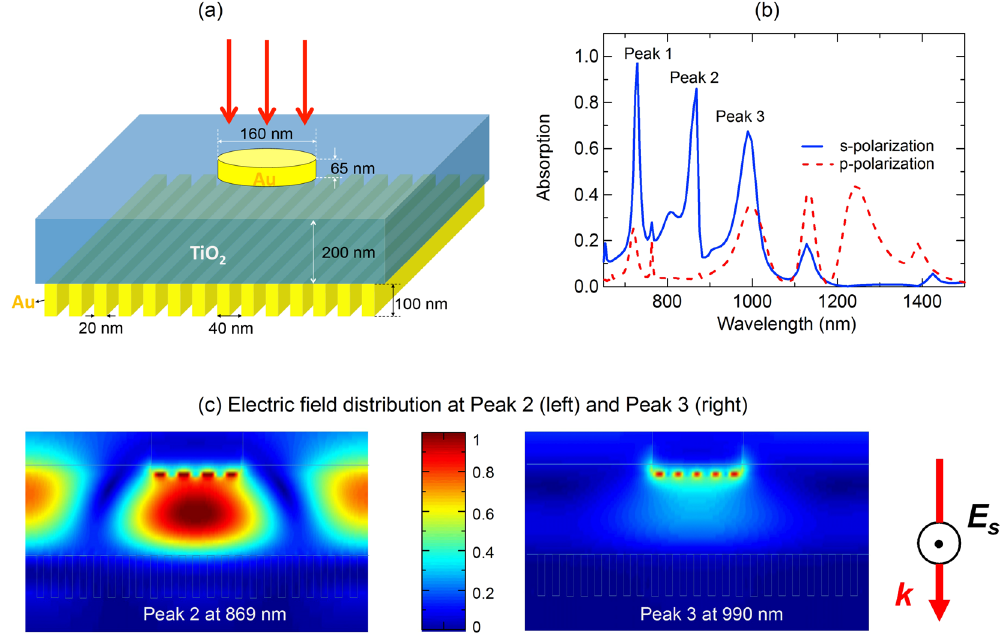
Figure 6. ( a ) Schematic of the narrowband polarization sensitive perfect absorber. Au nano-disk has diameter of 160 nm and thickness of 65 nm. TiO2 layer has thickness of 200 nm, and the Au grating has period of 40 nm, with filling factor of 0.5 and thickness of 100 nm. ( b ) Absorption for s-and p-polarization under normal incidence. ( c ) Electric field distributions at Peak 2 (left) and Peak 3 (right) for